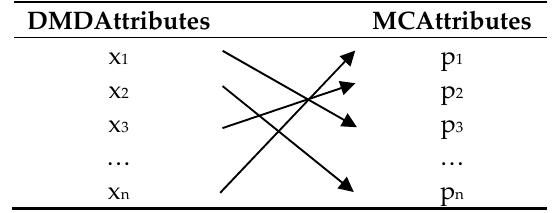
Table 5. Structured Data eXchange (SDX) Mapping between DMD and MCAttributes.